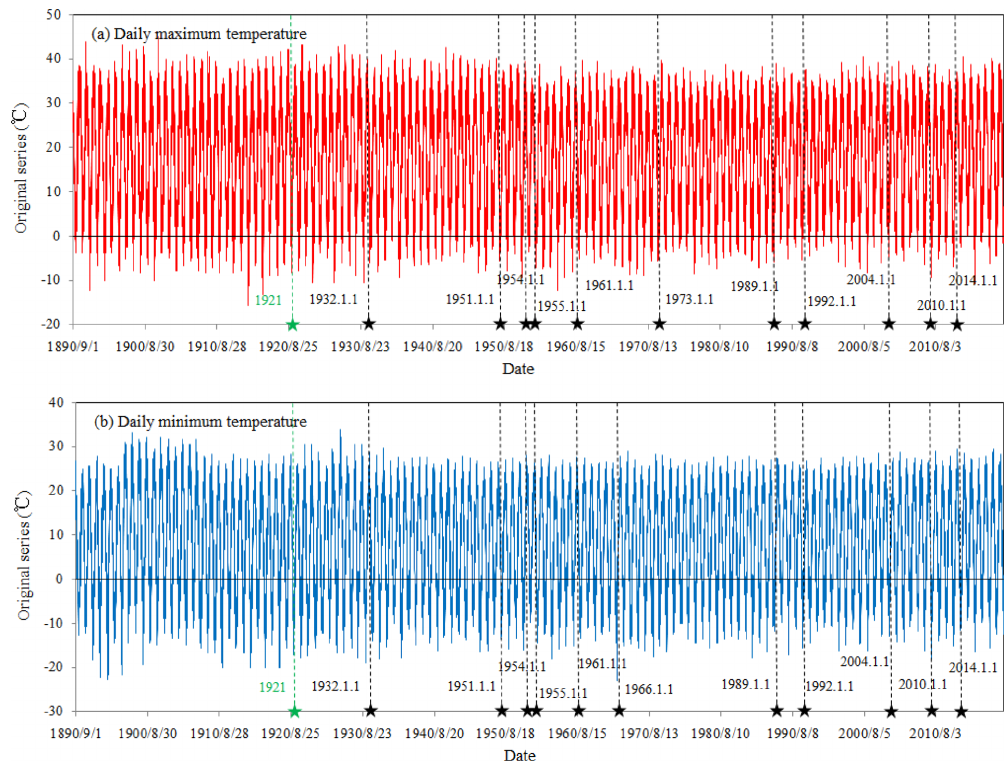
Figure 2. Original series of daily maximum temperature (a) and minimum temperature (b) at Tianjin Meteorological Observation Station covering 1 September 1890–31 December 2019. Black stars with vertical dashed lines on the axes mark metadata times (the relocation point in 1921 is marked by green star with vertical dashed line due to no specific